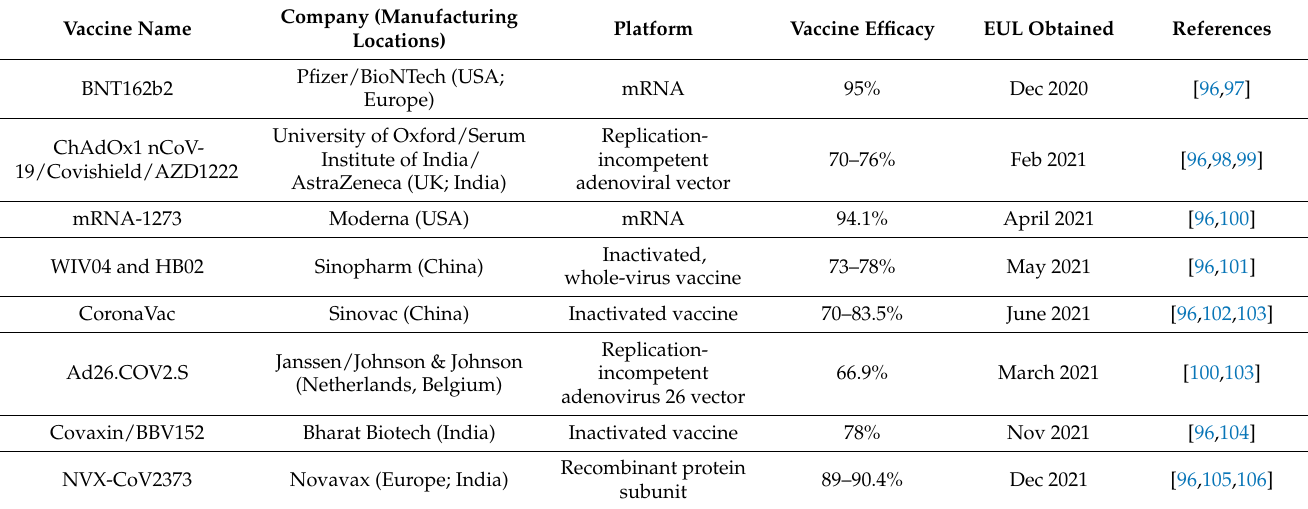
Table 4. List of COVID-19 vaccines cleared for emergency use license by